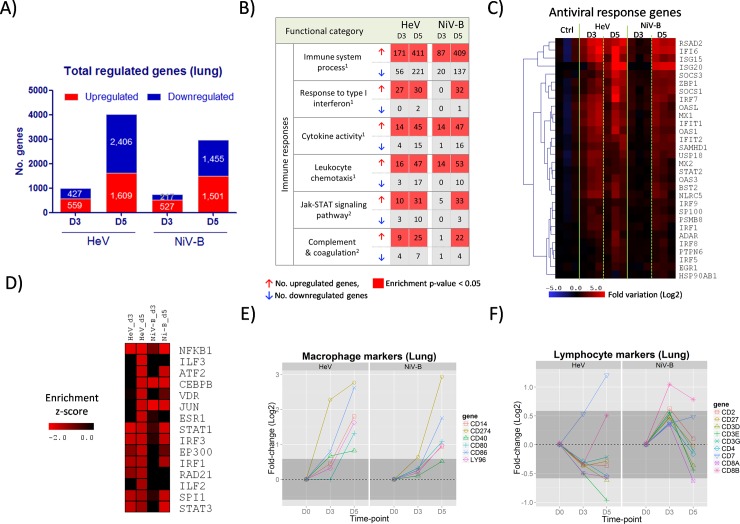
Gene expression profiles in the lung tissue of ferrets infected with HeV and NiV-B.Ferrets were infected with 5,000 TCID50 of HeV and NiV-B and euthanized at 3 and 5 d.p.i. and together with an uninfected control group (n = 3 per group). Transcriptomic analysis of the lung tissue was performed by RNA-seq. A) Number of significantly up- and down-regulated genes with respect to the control group (fold-variation>±1.5 and FDR<0.05) at 3 and 5 dpi. B) Functional gene classification of differentially expressed genes. For each time-point, up- and down-regulated genes were subjected to functional classification and a selected group of gene categories from 1Gene Ontology and 2KEGG Pathways that are related with the immune responses are shown. For each functional category, the number of up- and down-regulated genes and the level of significance of the enrichment (Fisher’s exact test p-value) are indicated. C) Heatmap showing the level of activation of genes belonging to the Response to Type I Interferon category, which encompasses antiviral response genes, during the course of HeV and NiV-B infection. D) Functional enrichment of up-regulated genes that belong to protein-protein interaction (PPI) hubs of transcription factors. E-F) Evolution in the mRNA expression levels of selected macrophage markers and lymphocyte markers, respectively, during HeV and NiV-B infection. These sets of markers were selected from the literature according to their association with these two cell populations, and their coordinated upregulation reflects an increase of the associated cell population in the tissue. Dark grey shaded areas indicate no variation with respect to the control group (<±1.5 fold-change).